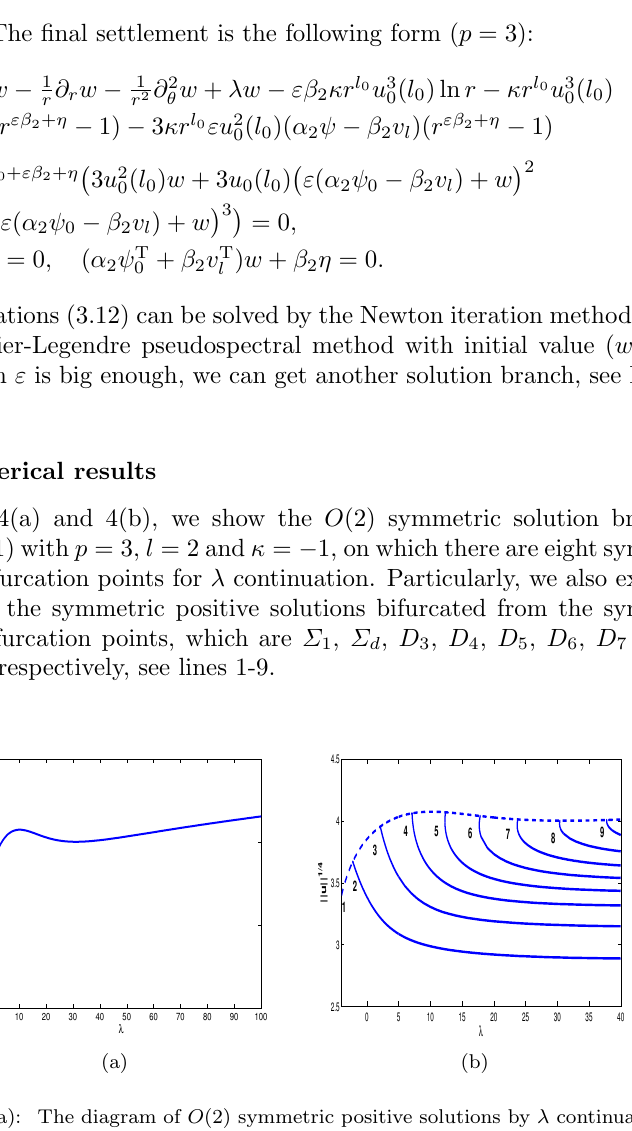
Figure 4. (a): The diagram of O (2) symmetric positive solutions by λ continuation with κ = − 1 , p = 3 and l = 2; (b):Symmetric positive solutions bifurcated from O (2) symmetric positive solution branch with κ = − 1 , p = 3 and l =